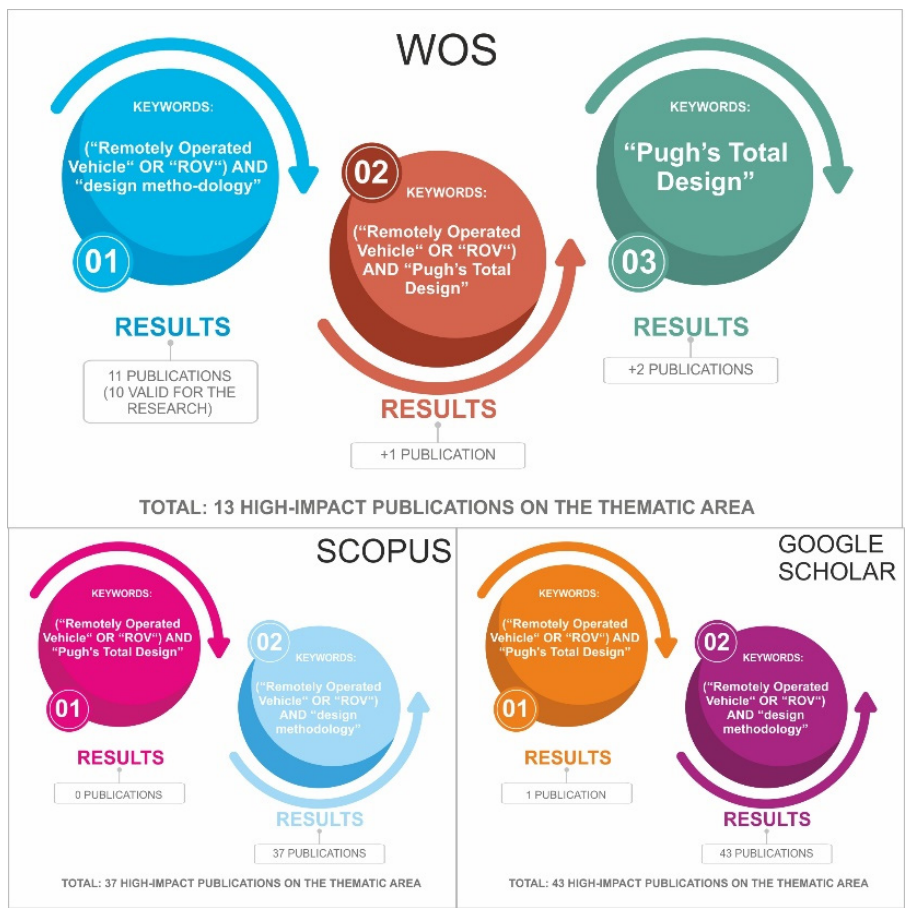
Figure 4. Proposal and results of bibliographic review.